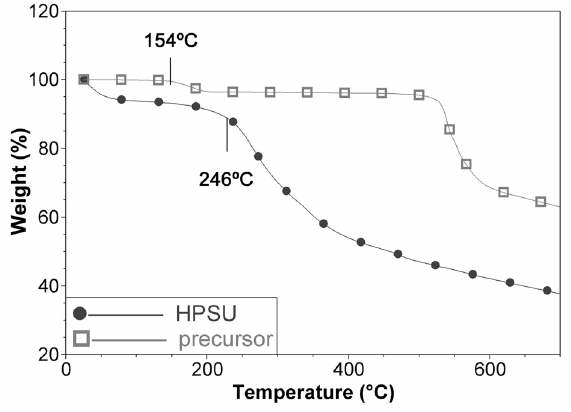
Figure 3. TGA comparison of HPSU and its precursor